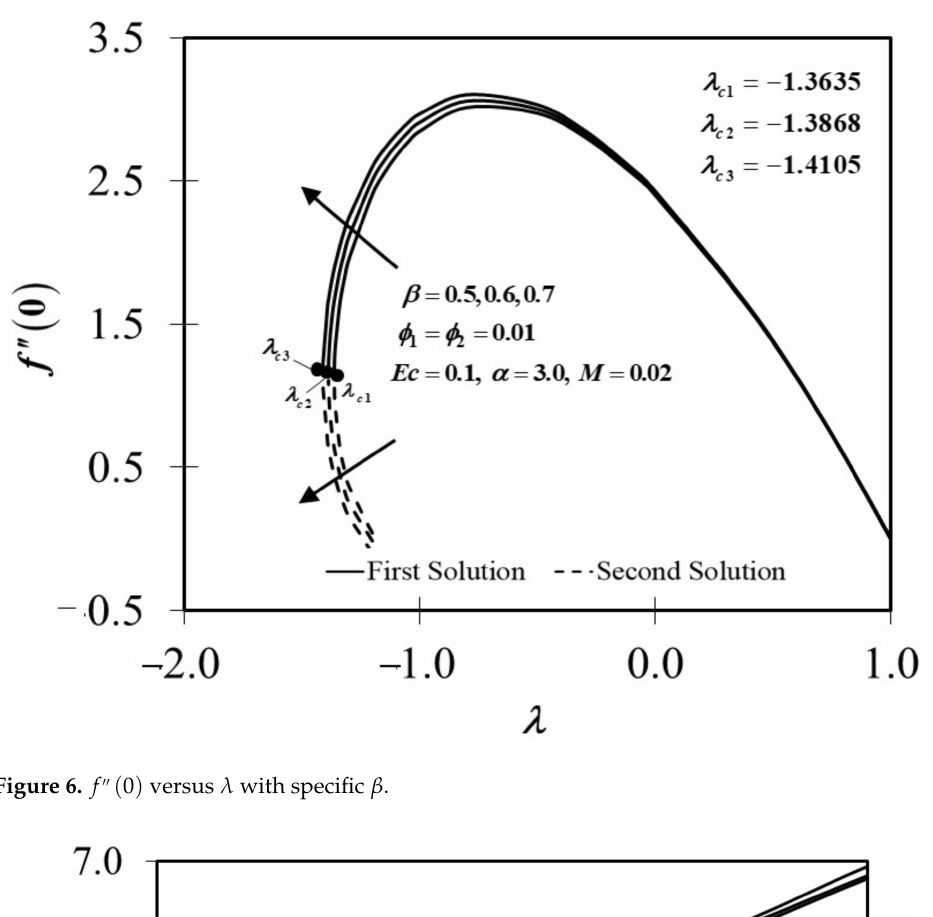
Figure 6. f (cid:48)(cid:48) ( 0 ) versus λ with specific β .